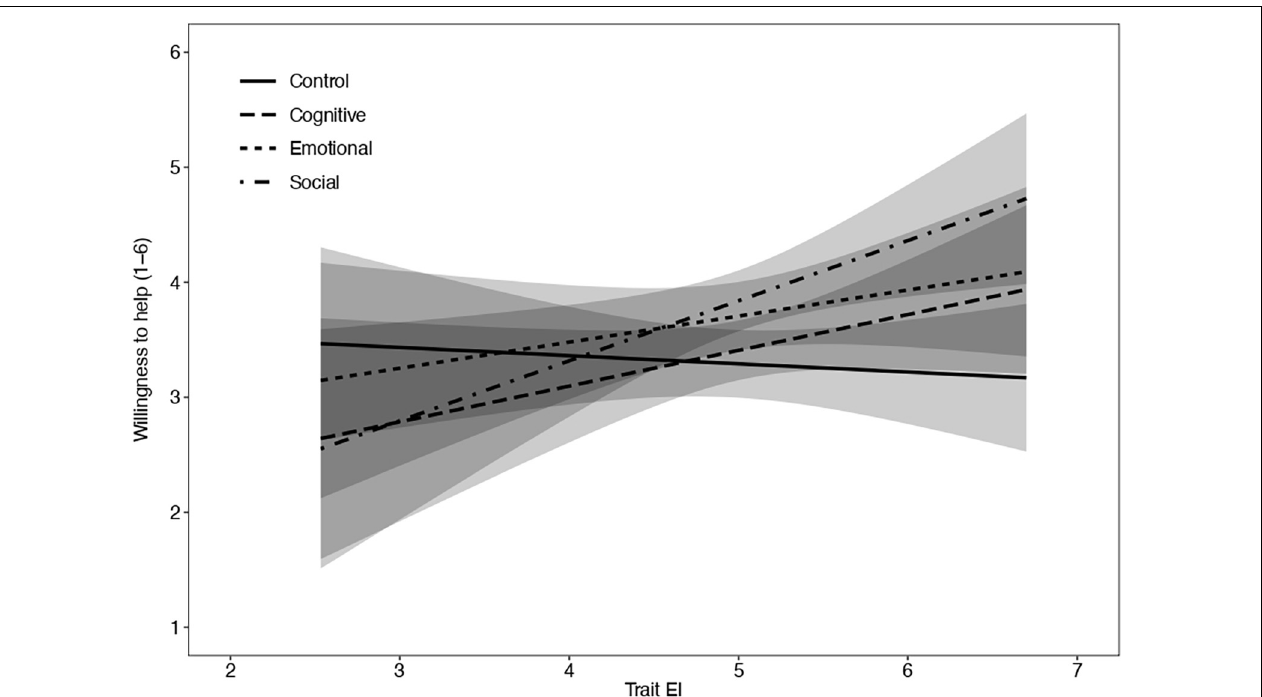
FIGURE 2 | Simple slope of trait emotional intelligence predicting willingness to help for control, cognitive, emotional, and social conditions. The x-axis represents the score of trait EI, and the y-axis represents the degree of willingness to help. Conditions are represented by the types of